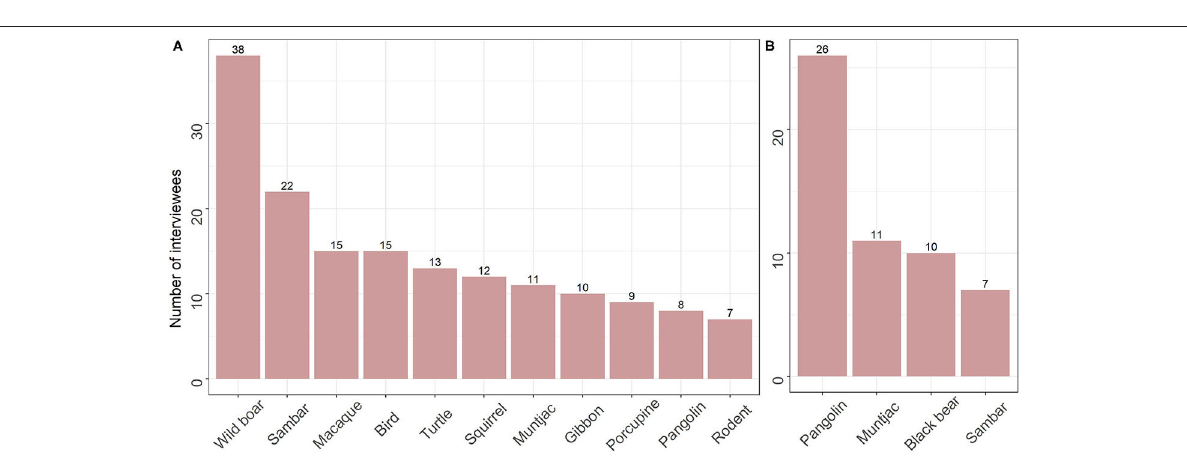
perceived as being locally extirpated. Older people (estimate = 0.033, standard error = 0.015, z -value = 2.283, p = 0.022) and people in Qingsong (estimate = 1.819, standard error = 1.819, z -value = 2.760, p = 0.015) compared to Bawang were more likely to identify at least one locally extirpated species ( Supplementary Table 3